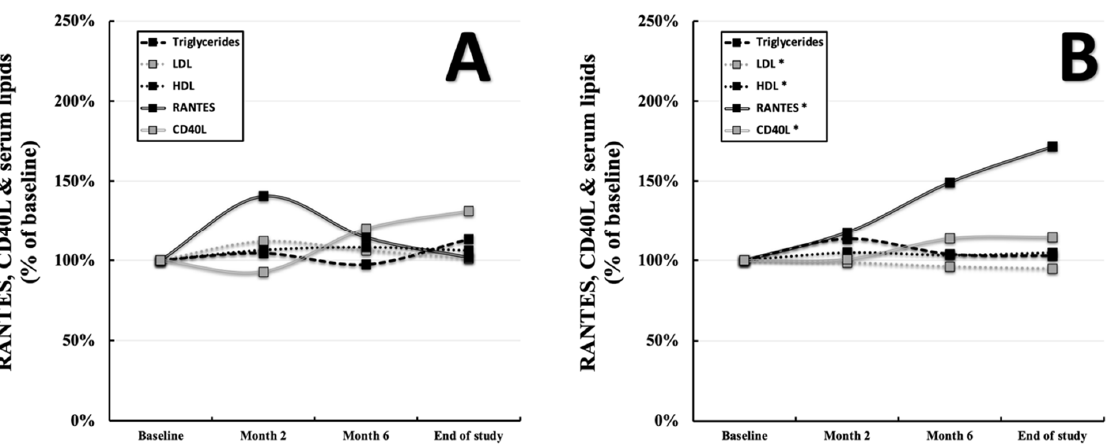
Figure 4. Progression of RANTES, CD40L, HDL, LDL, and serum triglycerides in groups A (perfor- mance gain of <3%, n = 27, ( A )) and B (performance gain of ≥ 3%, n = 71, ( B )) over the course of 8 months. ”*” indicates a two-tailed p -value of p < 0.05 comparing baseline values to those at the end of the